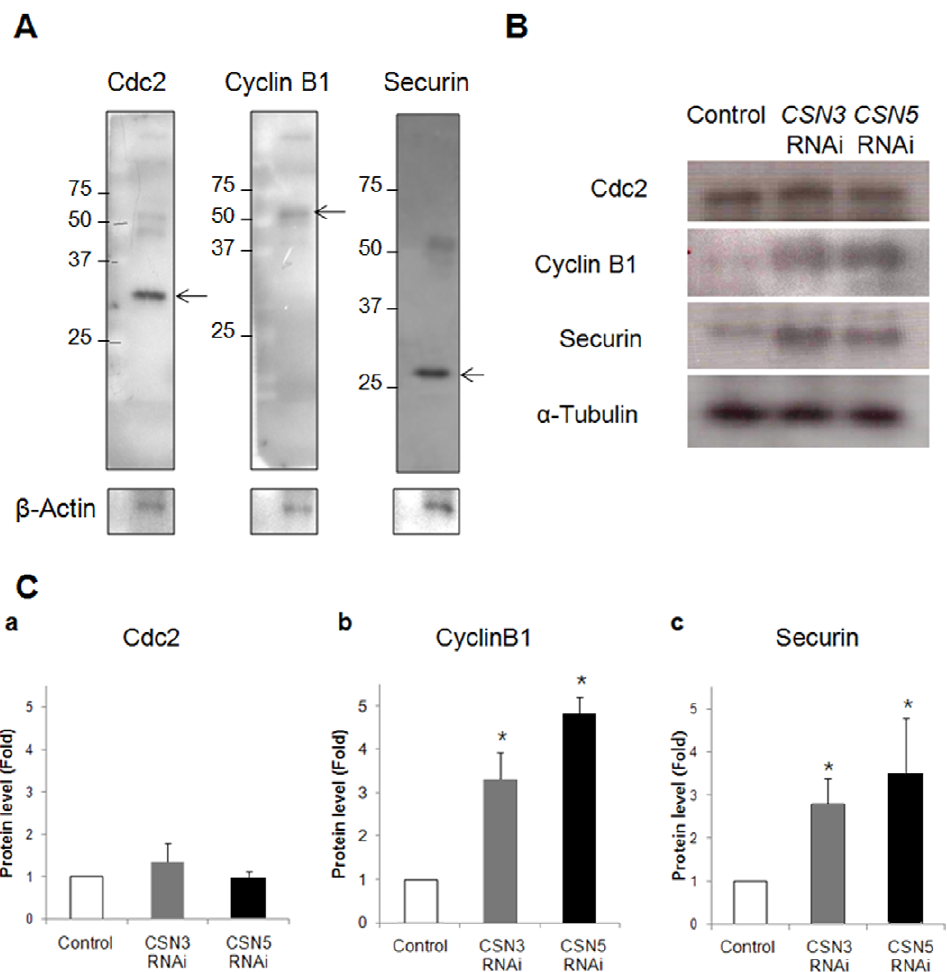
Figure 8. The level of APC/C substrates changed following CSN3 or CSN5 knockdown. (A) Western blot analysis of Cdc2, Cyclin B1, and Securin by using 100 oocytes. Numbers on the left side of the band indicate the sizes (kDa) of the protein markers, while arrows indicate the specific proteins. (B) Western blot analysis of Cdc2, Cyclin B1, and Securin by using 100 oocytes. (C) Relative protein level of each band was calculated and presented as the mean 6 SEM by measuring the area and data are presented in comparison to appropriate control bands for each protein. Asterisks indicate statistically significant differences compared to control group (p , 0.05).